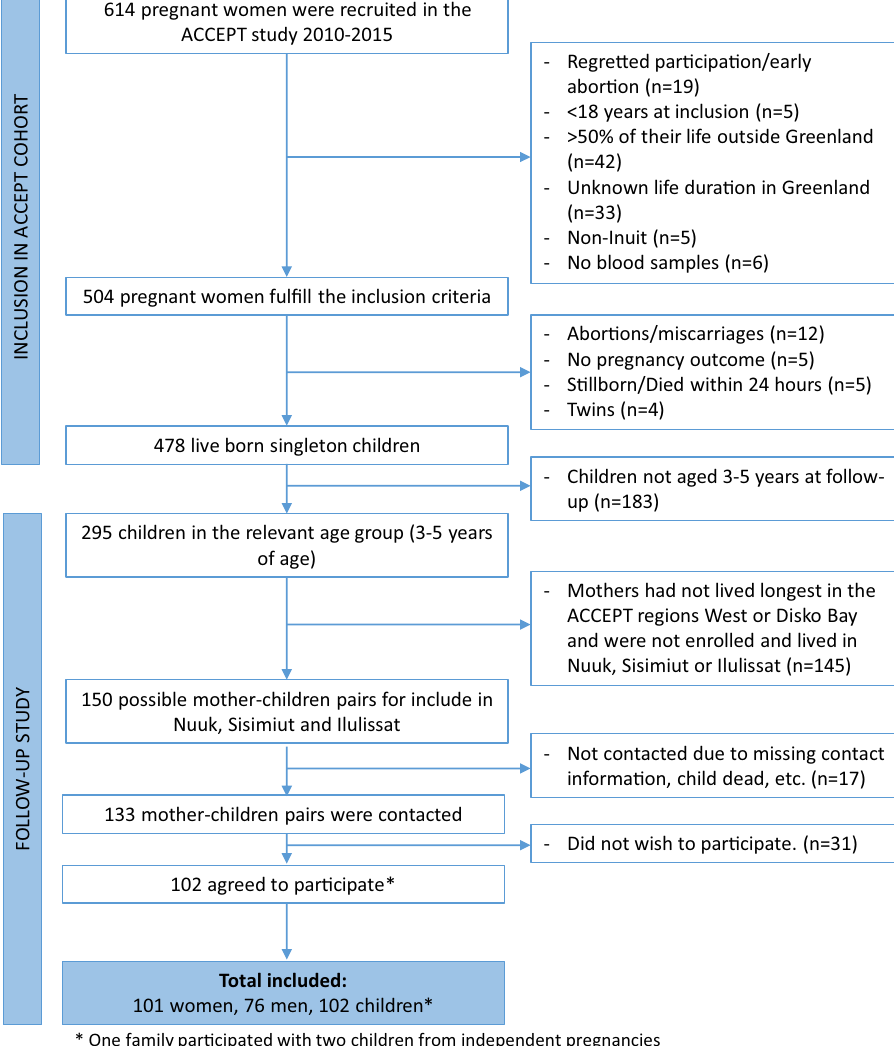
Figure 1. Flowchart showing the process of inclusion and exclusion of mother–child pairs for the ACCEPT follow-up